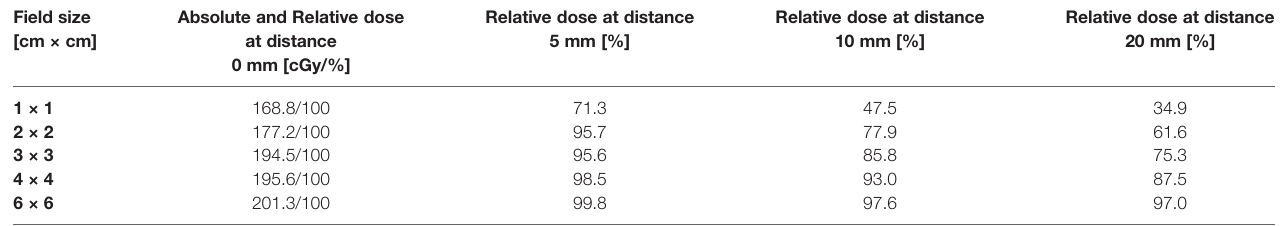
TABLE 3 | Relative dose according to fi eld size and surface bolus distance in mm. Field size Absolute and Relative dose [cm × cm] at